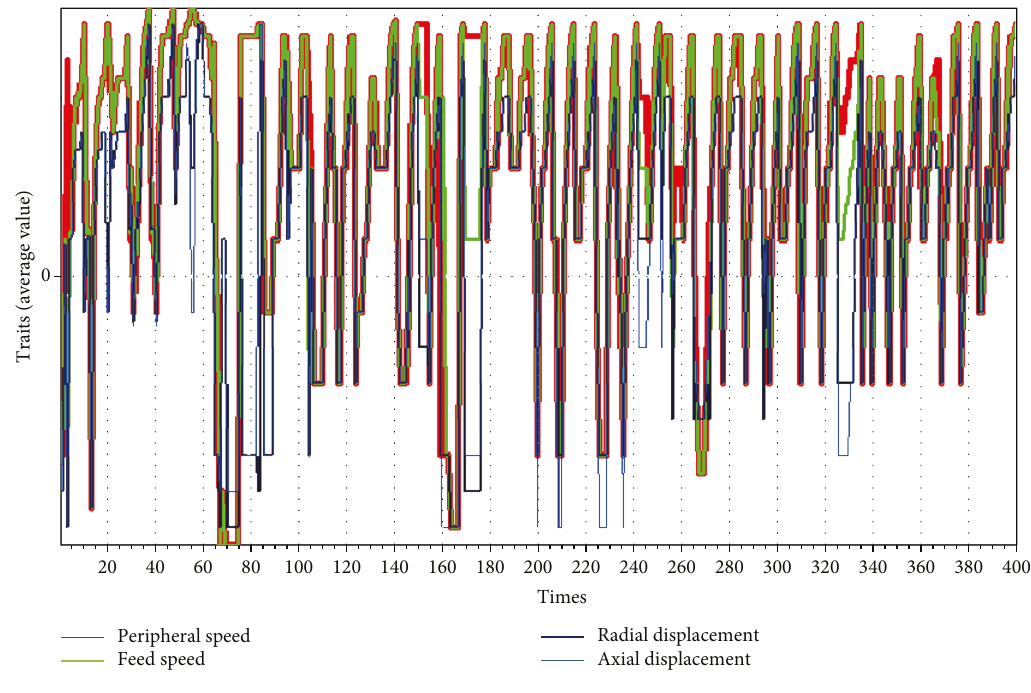
Figure 12: The correlation between the output